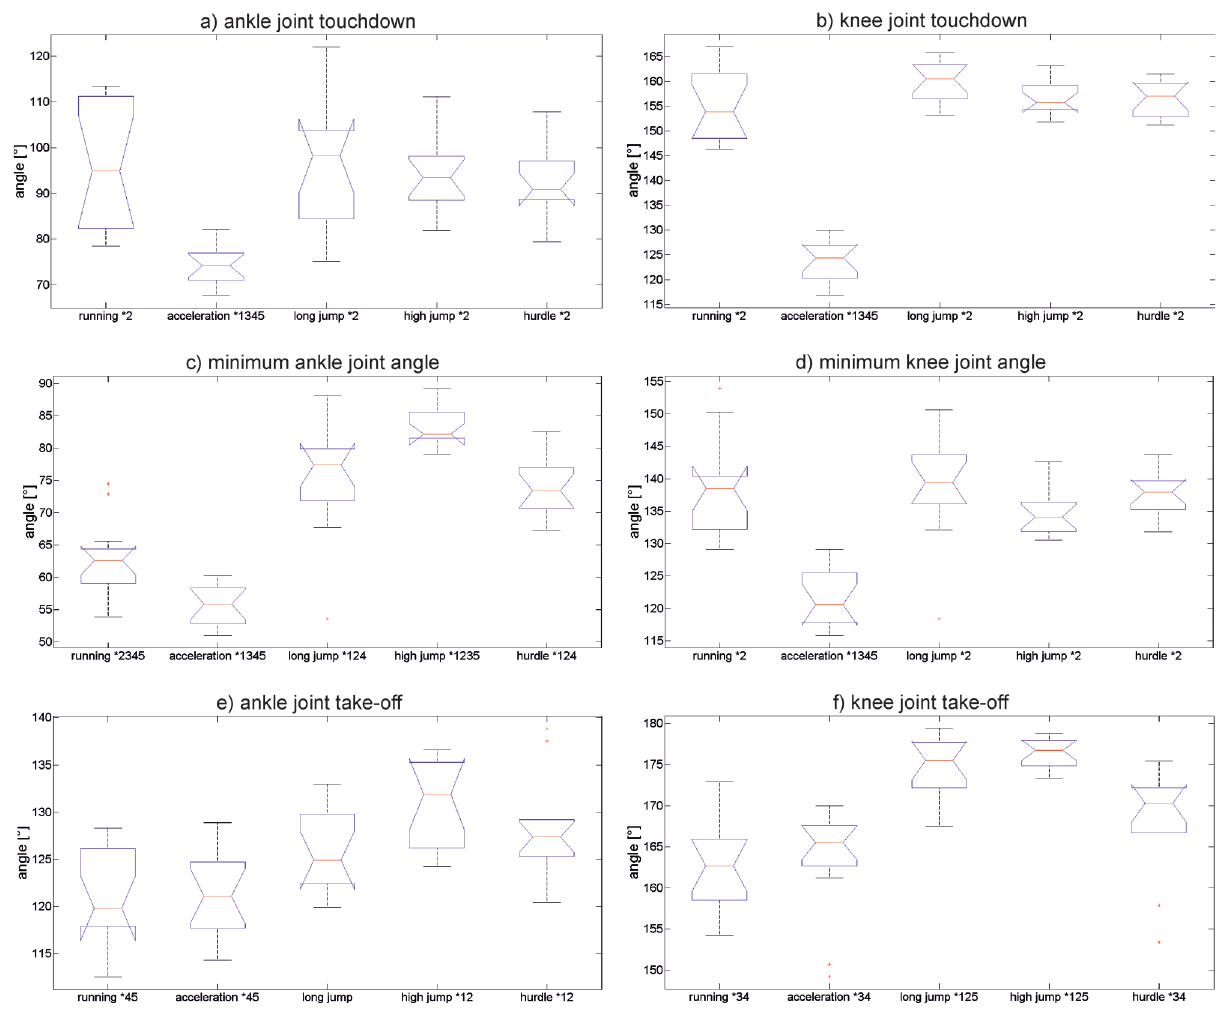
Figure 2. Angles in the ankle and knee joint during support phase. Box graphs display the range values of the vari- ous take-off types at the instant of touch-down (a, b), maximum joint flexion (c, d) and at the instant of take-off (e, f). Left column belongs to characteristic of ankle joint angles, right column displays knee joint characteristics. Sig- nificant differences between types of take-off are denoted with * followingly: *significantly different ( p < .05) from: 1 – running, 2 – acceleration running, 3 – long jump, 4 – high jump, 5 – hurdle.